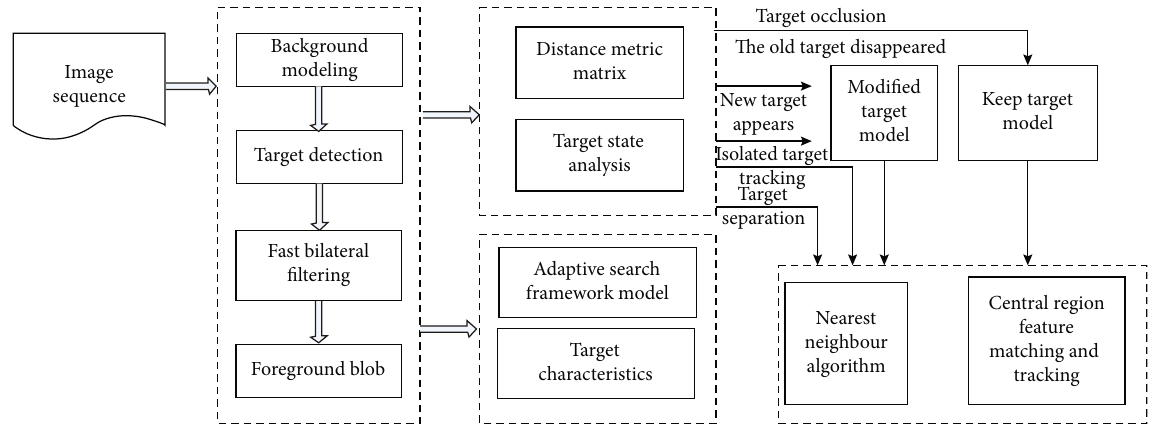
Figure 3: Multiperson target dynamic tracking block